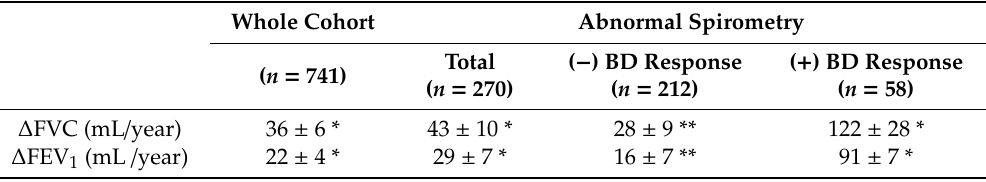
Table 3. Longitudinal change in spirometry parameters.